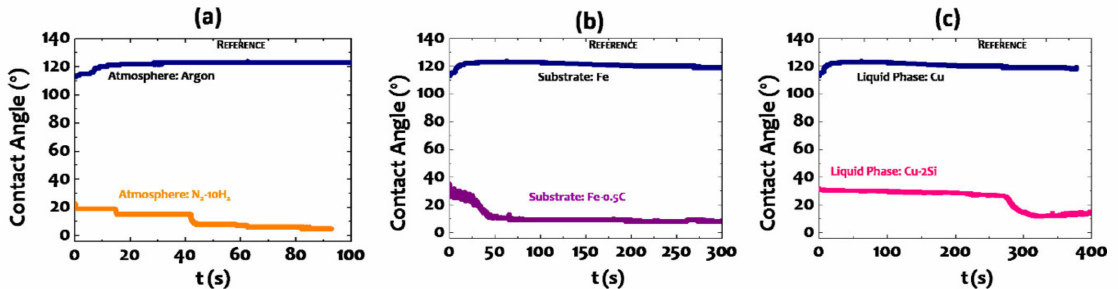
Figure 8. Influence of different parameters on the wetting behaviour of liquid Cu on Fe-based substrates: ( a ) influence of the atmosphere; ( b ) influence of the composition of the substrate Fe or Fe-0.5%C; ( c ) influence of the liquid –Cu or Cu-Si that assists the metallothermic reaction